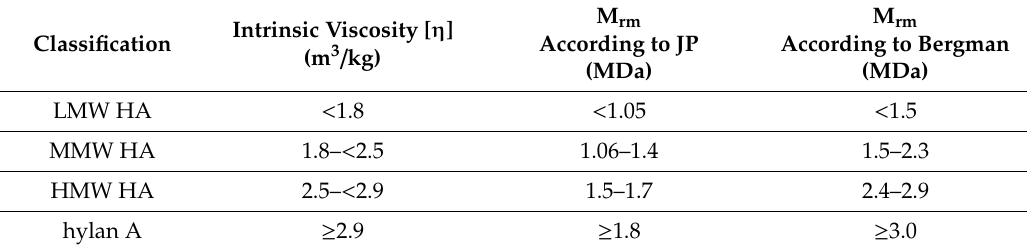
Table 2. Terminology proposed to define the relation between the hyaluronan average molecular weight ranges in eye drops and its intrinsic viscosity values.